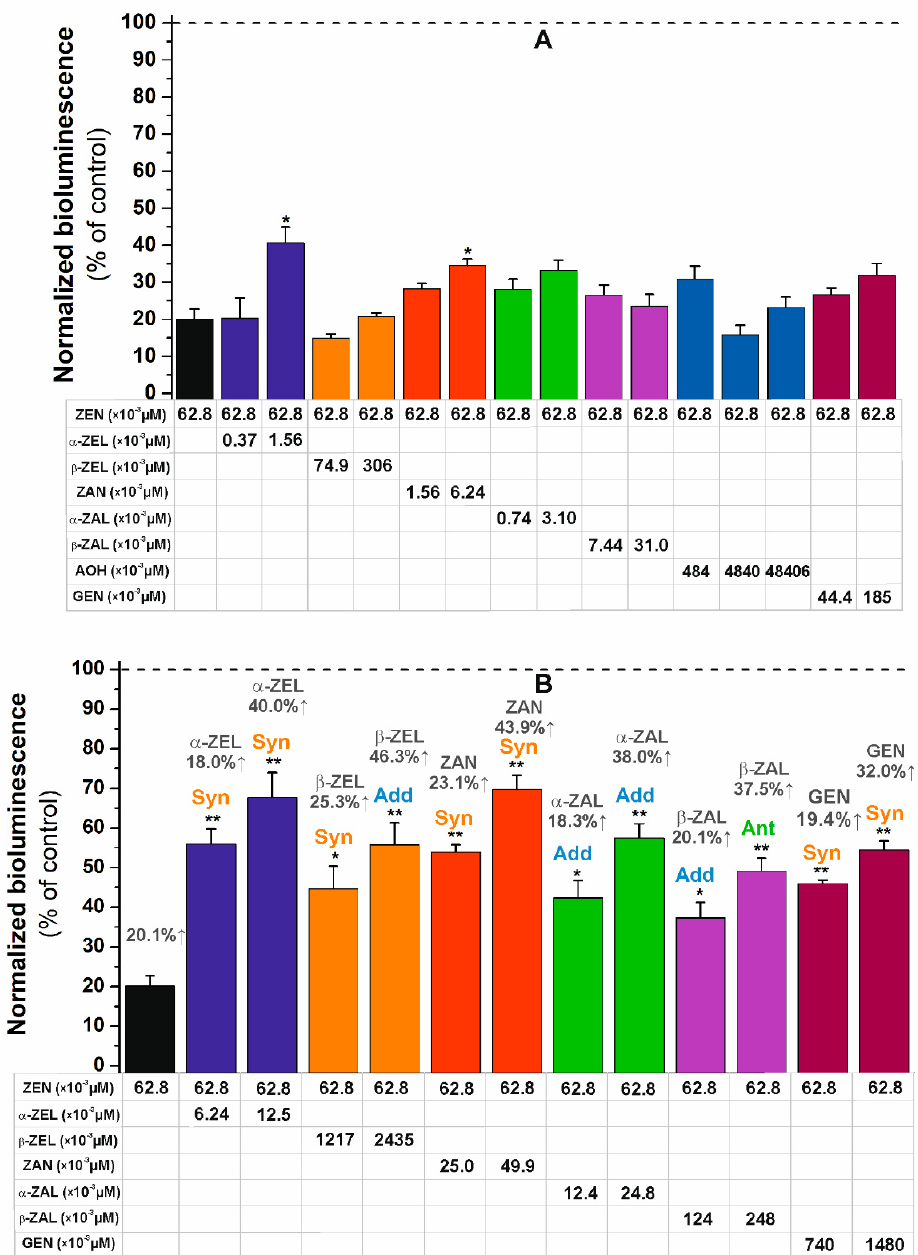
Figure 5. Estrogenic effects of ZEN alone and in combination with the subtoxic (non-estrogenic; ( A )) or toxic (estrogenic; ( B )) concentrations of α -ZEL, β -ZEL, ZAN, α -ZAL, β -ZAL, AOH, and GEN based on the BLYES ( Saccharomyces cerevisiae ) assay (* p < 0.05 and ** p < 0.01). The individual effects of mycotoxins at the concentrations applied are demonstrated with a dark grey color ( B ).